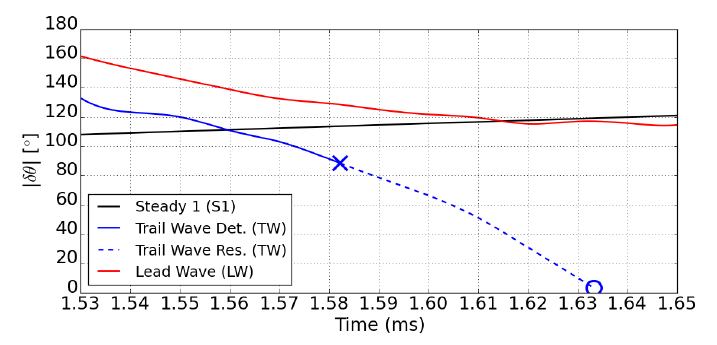
Figure 14. Angluar separations of Steady 1, trailing, and leading waves relative to Steady wave 2 ( ± 1.3 ◦ to 3.6 ◦ ).